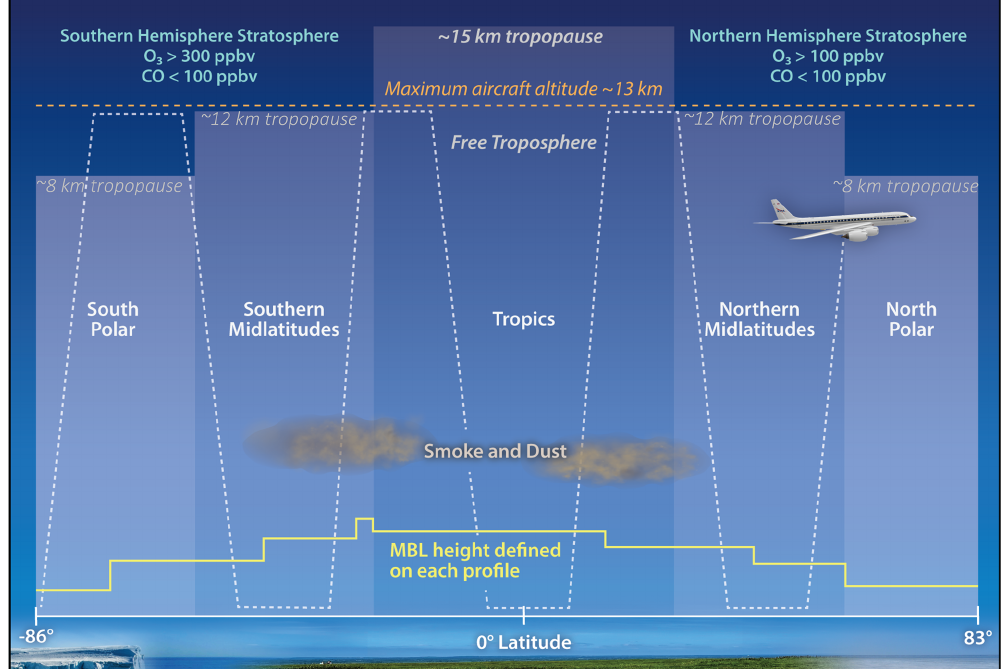
Figure 8. Schematic representation of the air mass classification scheme. The boundaries between the polar, midlatitude, and tropical air masses vary for each ATom deployment and ocean basin, and they are listed in Table S1 in the Supplement. Data taken in biomass burning smoke (“smoke”) and mineral dust (“dust”) plumes are combined when concentration criteria are met (Sect. 2.3) regardless of latitude, while stratospheric regions are separated into Northern or Southern Hemisphere because of different aerosol characteristics in each (Murphy et al.,